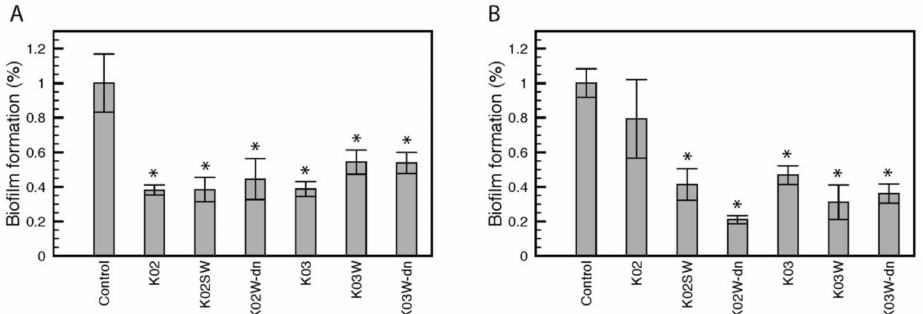
Figure 5. Effect of kefir on biofilm formation. The effect of kefir beverages (K02 and K03), kefir whey (K02W and K03W), and denaturized kefir whey (K02W-dn and K03W-dn) on biofilm formation was evaluated for Pseudomonas aeruginosa ( A ) and Cobetia marina ( B ). Results are expressed as biofilm formation ratio compared to the control condition. Samples were evaluated in triplicates and error bars represent standard deviation. Asterisks denote statistically significant changes ( p <